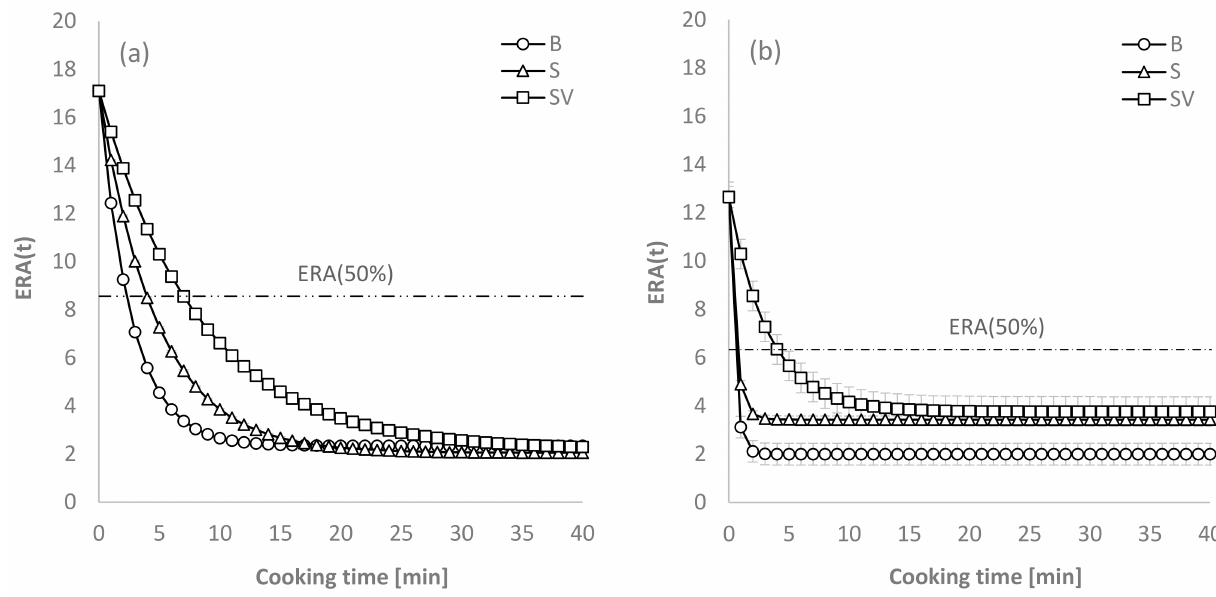
Figure 9. Tissue decompartmentalization kinetics of Depurple ( a ) and Cheddar ( b ) cauliflower under boiling (B), steaming (S), and sous-vide (SV) as described by the ERA parameter (intended as an indirect measure of the loss of cell wall integrity and of the easy of extractability of sterols and